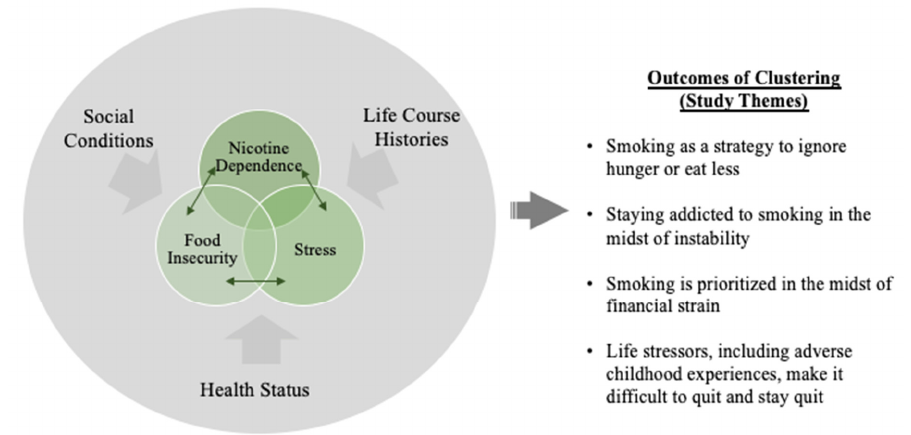
Figure 1. A Proposed Conceptualization of Clustering of Conditions Contributing to Nicotine Dependence, Food Insecurity, and Stress.